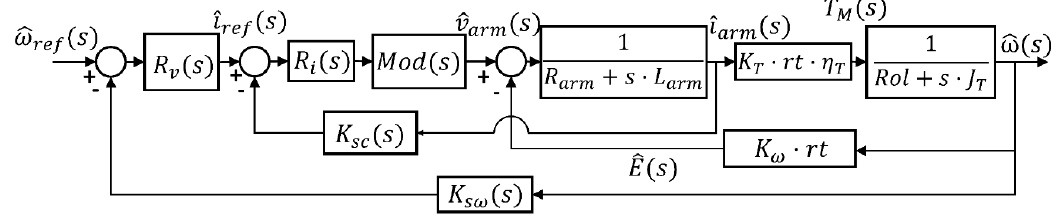
Figure 7. Block diagram of the small-signal model of DC motor and vehicle together with the control loops.